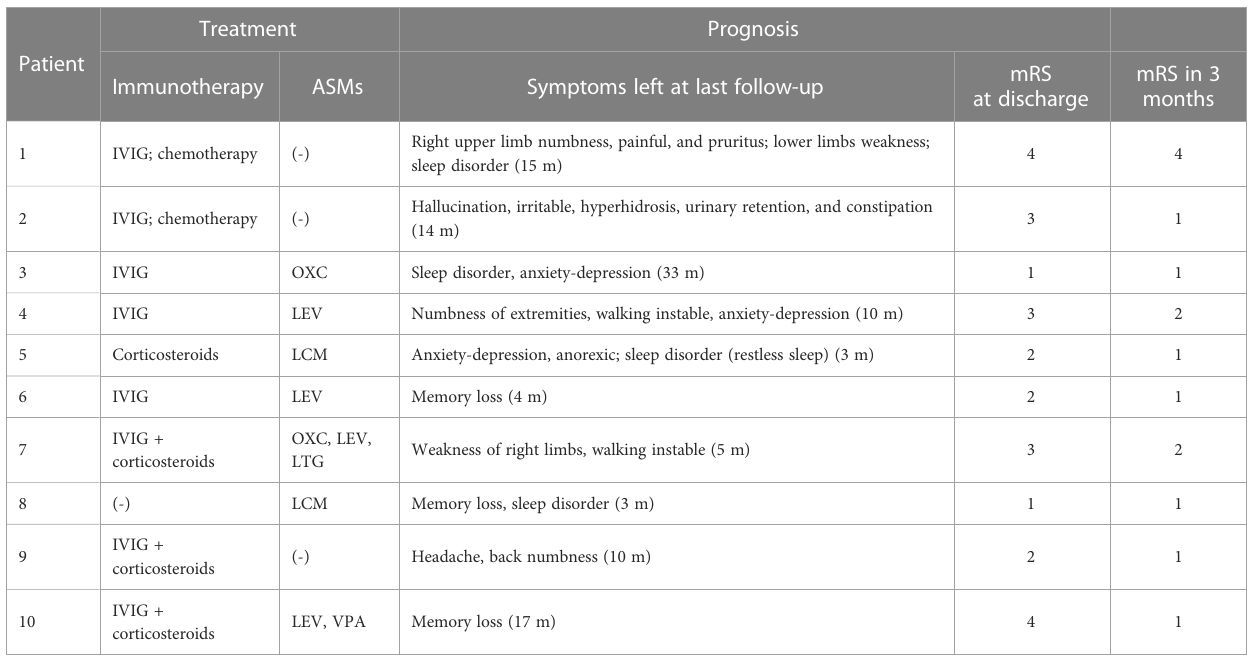
TABLE 3 Treatment and prognosis of anti-amphiphysin